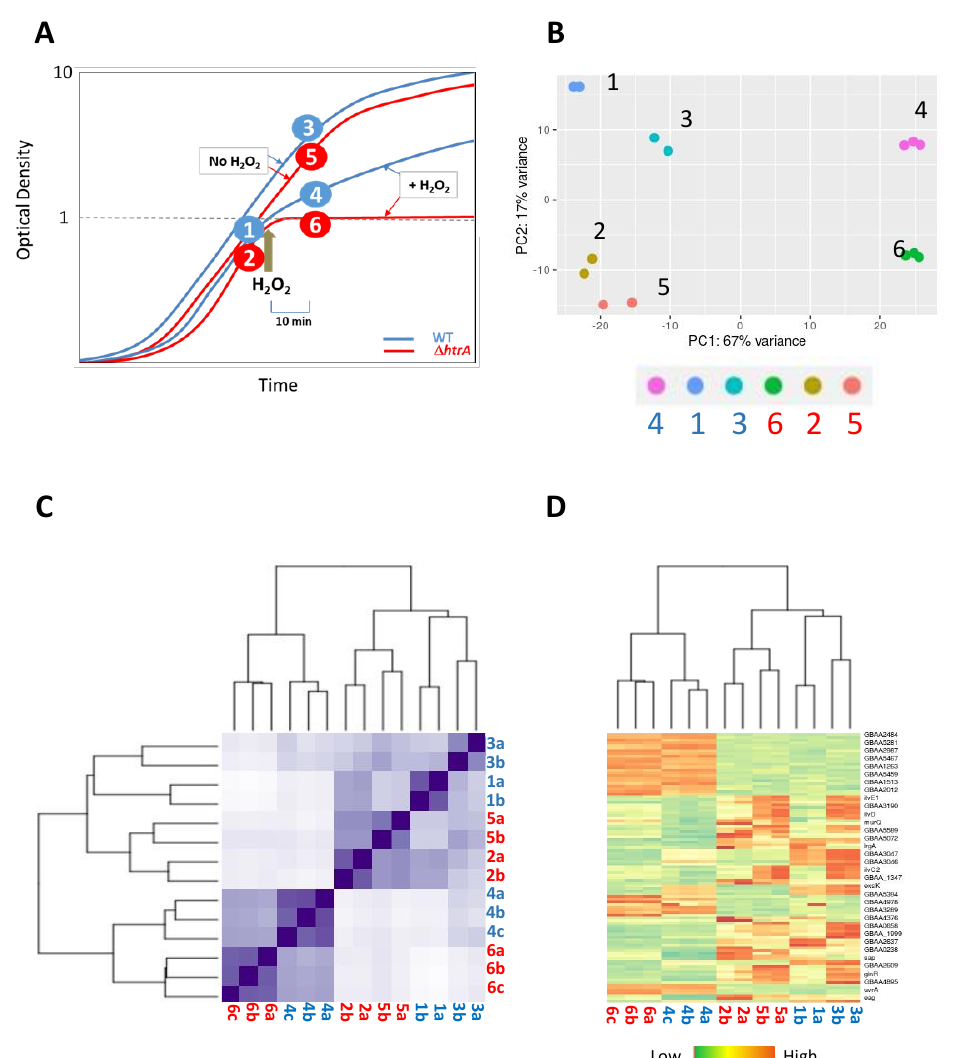
Figure 2. ( A ) Schematic representation of the cultures which served for collecting the WT and ∆ htrA samples for transcriptomic analysis. All WT samples (samples 1, 3, and 4) as well as the growth curve are in blue while those of the ∆ htrA strain (samples 2, 5, and 6) are in red. Samples 1 and 2 were collected before dividing each culture into tween flasks and continuing growth in the presence (samples 4 and 6) or absence (samples 3 and 5) of 3 mM H 2 O 2 . Samples 3–6 were collected 10 min after the onset of H 2 O 2 treatment. Samples 1, 2, 3, and 5 were done in duplicates (marked a and b, see below), and samples 4 and 6 were done in triplicates (marked a, b, and c, see below). The RNA seq transcriptomic data of all samples were deposited to the NCBI database (as detailed in [55]). ( B ) Principal component analysis (PCA; after regularized log transformation) of gene expression of the various transcriptomes indicated in panel A. The dots represent distinct replicates (duplicates for samples 1, 2, 3, and 5, and triplicates for samples 4 and 6); their clustering indicating high similarity, underlines the reproducibility of the transcriptomic data. ( C ) Correlation heatmap of Euclidean sample distances after regularized log transformation. The dendrograms on the left and upper sides indicate hierarchical clustering of the duplicate and triplicate samples. Note also the similarity between transcriptomes 1 and 3 and between transcriptomes 2 and 5, which represent cultures grown in the absence of H 2 O 2 , as indicated in panel 1. ( D ) Heatmap diagram of the relative expression level of the 100 genes with the highest variance across samples. Similar to panel C, the dendrogram at the top indicate hierarchical clustering of the duplicate and triplicate samples as well as the similarity between the H 2 O 2 treated and untreated-culture transcriptomes in each of the 2